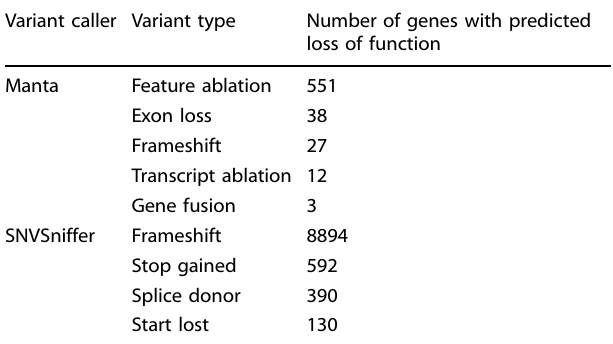
Table 1. Variant type-based distribution of genes with a predicted loss of